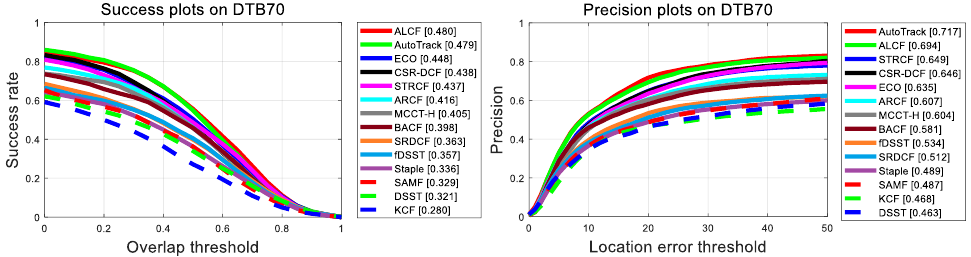
Figure 6. Overall performance of ALCF and other state-of-the-art trackers on VisDrone2018-test-dev.